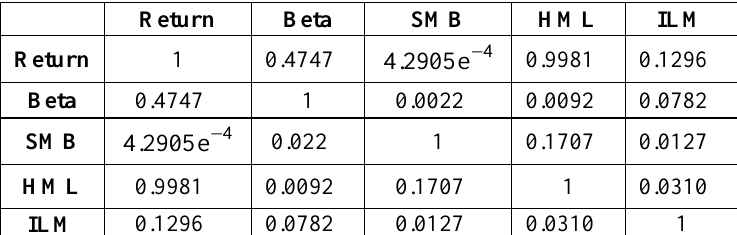
Table 6. The Probability of Significant Variables at the Sixth